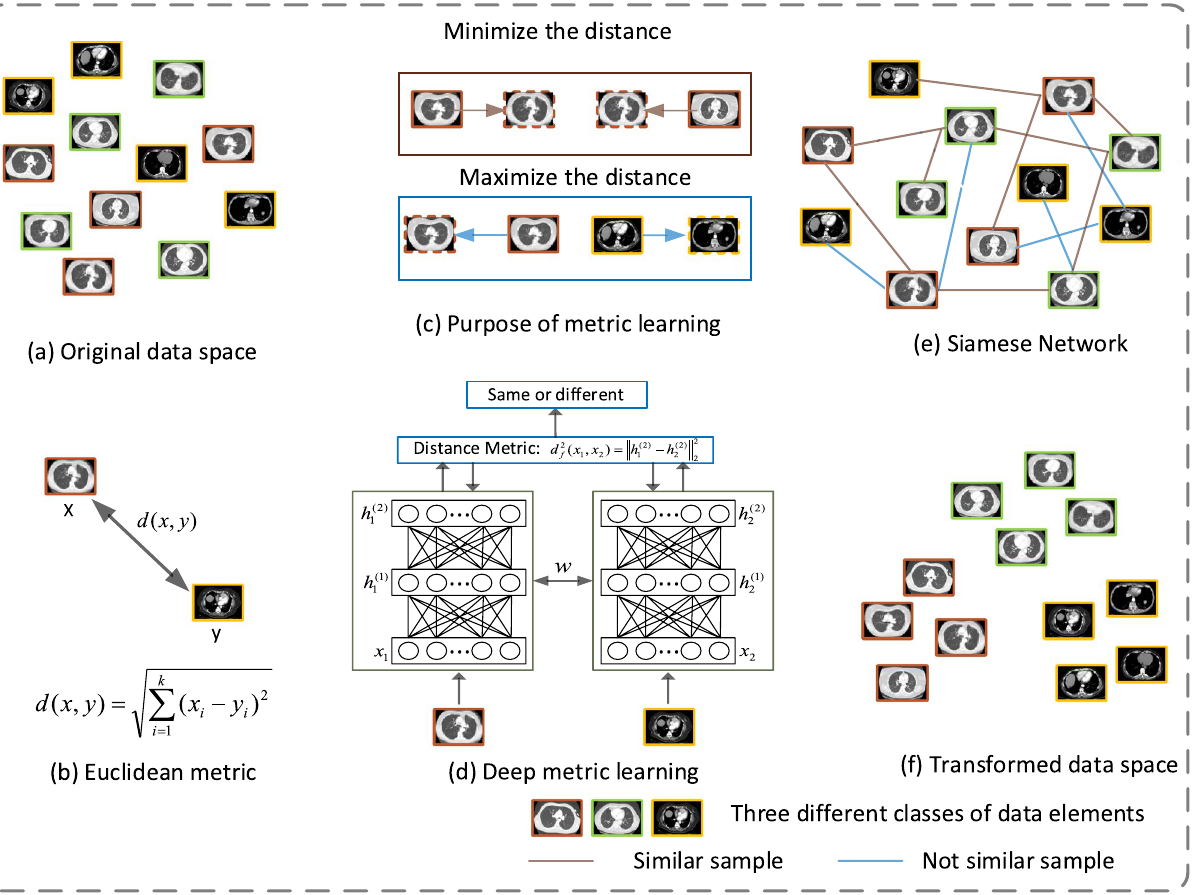
Figure 1. Block diagram of deep metric learning based on weakly supervised clustering ( a ) original data space ( b ) Euclidean metric ( c ) the purpose of metric learning ( d ) deep metric learning ( e ) Siamese network ( f ) transformed data